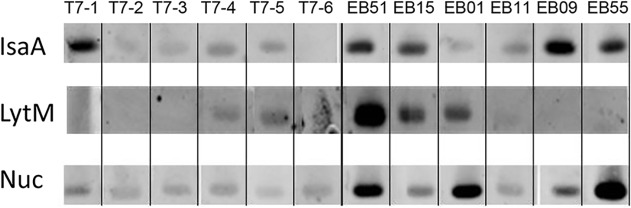
Western detection of immune responses against the antigens IsaA-His6, LytM-His6 and Nuc-His6.Sera of healthy volunteers (T7-1 till T7-6) and EB patients (EB51, 15, 01, 11, 09, 55) were used.